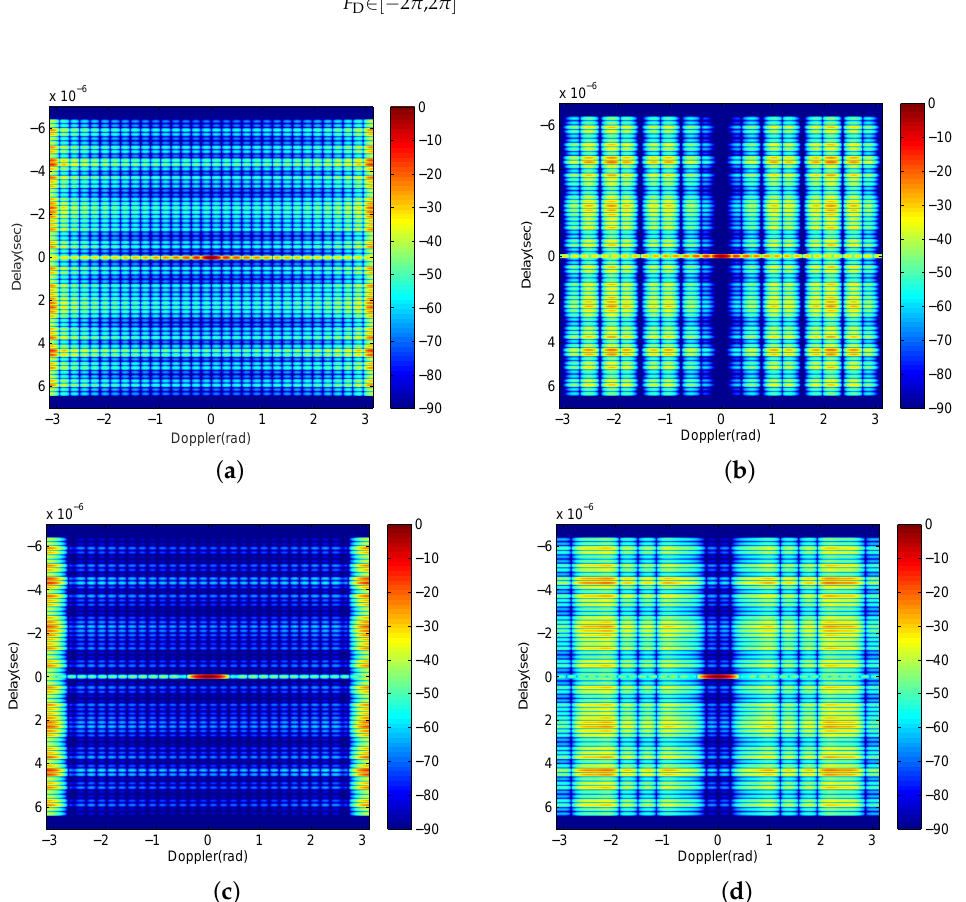
Figure 7. The AFs of some representative existing waveform design methods for Golay complementary waveforms (the unit of colorbar is dB). ( a ) Standard transmission order; ( b ) PTM Design algorithm; ( c ) Hamming amplitude weighting; ( d ) both PTM Design algorithm and Hamming amplitude weighting